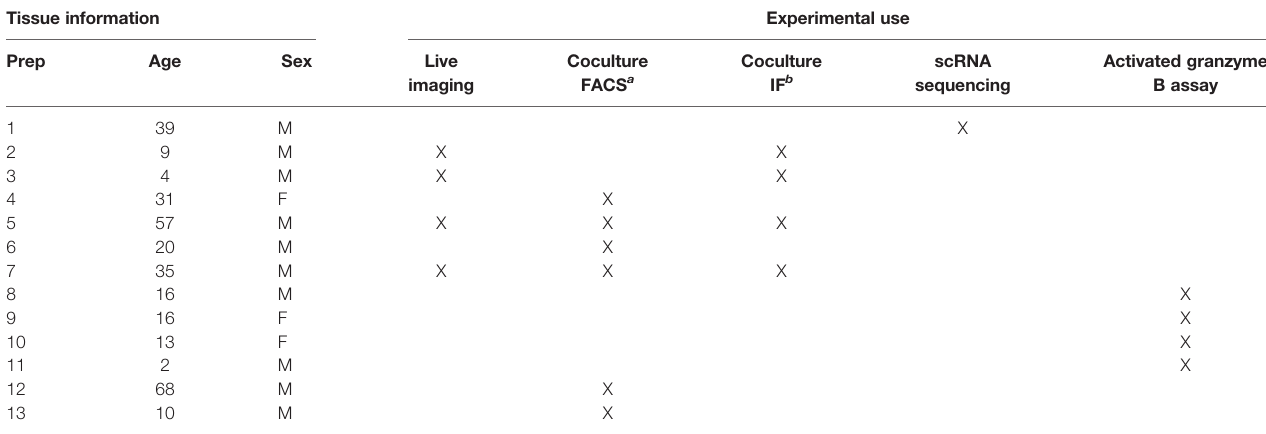
TABLE 1 | Human primary oligodendrocytes characterization and